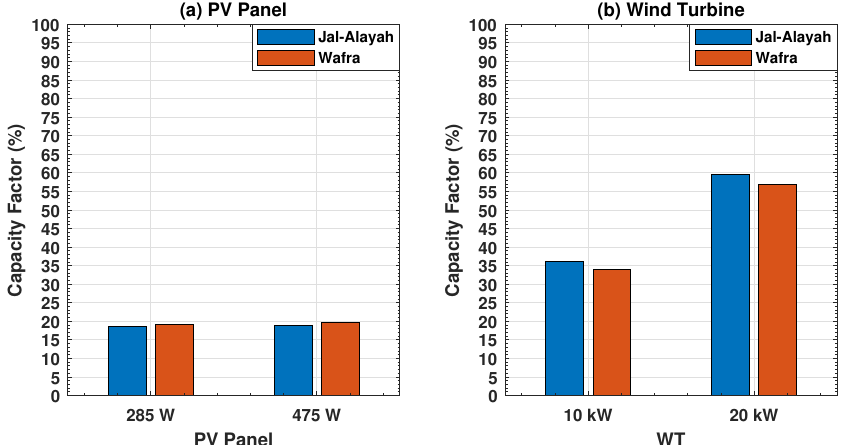
Figure 12. Capacity factor at Jal-Alayah and Wafra cell-sites for using ( a ) a PV Panel and ( b ) a Wind